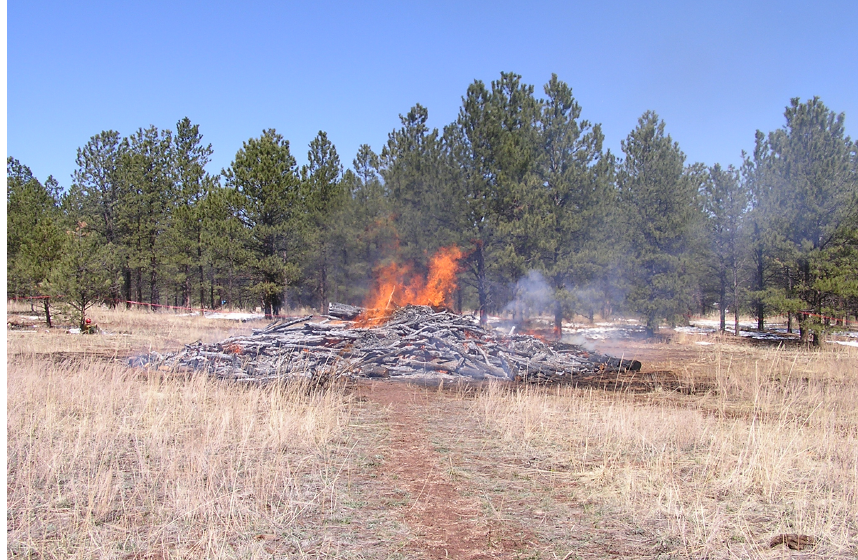
Figure 3. The slash pile of the MEF 26 April 2004 experimental burn about 75min after ignition. Image credit: John M.